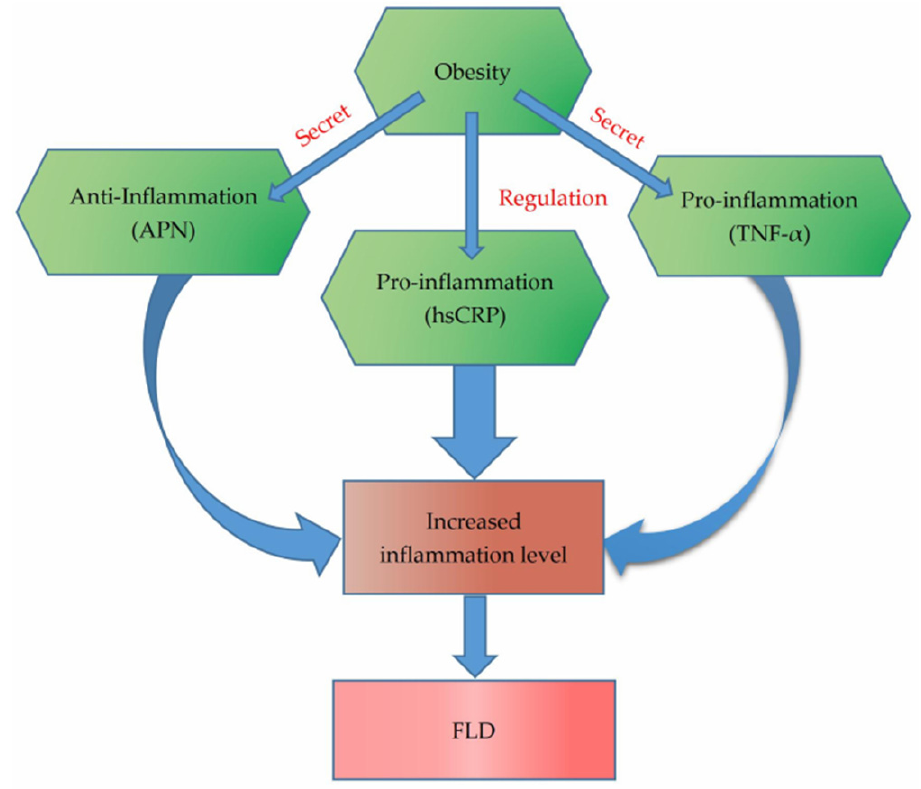
Figure 1. The relationship between obesity and fatty liver disease.